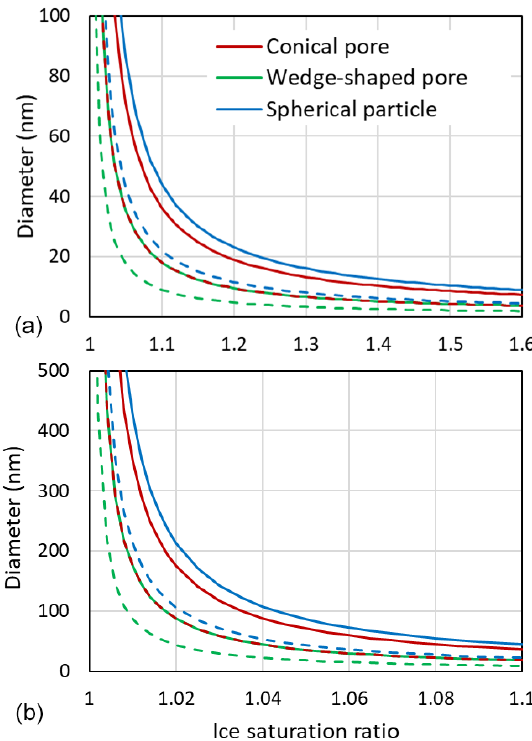
Figure 11. Diameters of pore openings allowing barrier-free ice growth out of cylindrical or conical pores (red), wedges or trenches (green), and spherical particles (blue) as a function of the ice saturation ratio. Panel (b) is a zoomed in view of panel (a) . Solid lines are obtained for T = 230K with γ vi = γ vw + γ iw = 0 . 0811Jm − 2 + 0 . 0226Jm − 2 = 0 . 1033Jm − 2 , γ iw from Ick15, and θ iw = 55 ◦ . Dashed lines are calculated by halving all involved in- terfacial tensions to account for the presence of trace amounts of organic substances that adsorb on surfaces and interfaces. Note that the dashed red line overlays the green solid